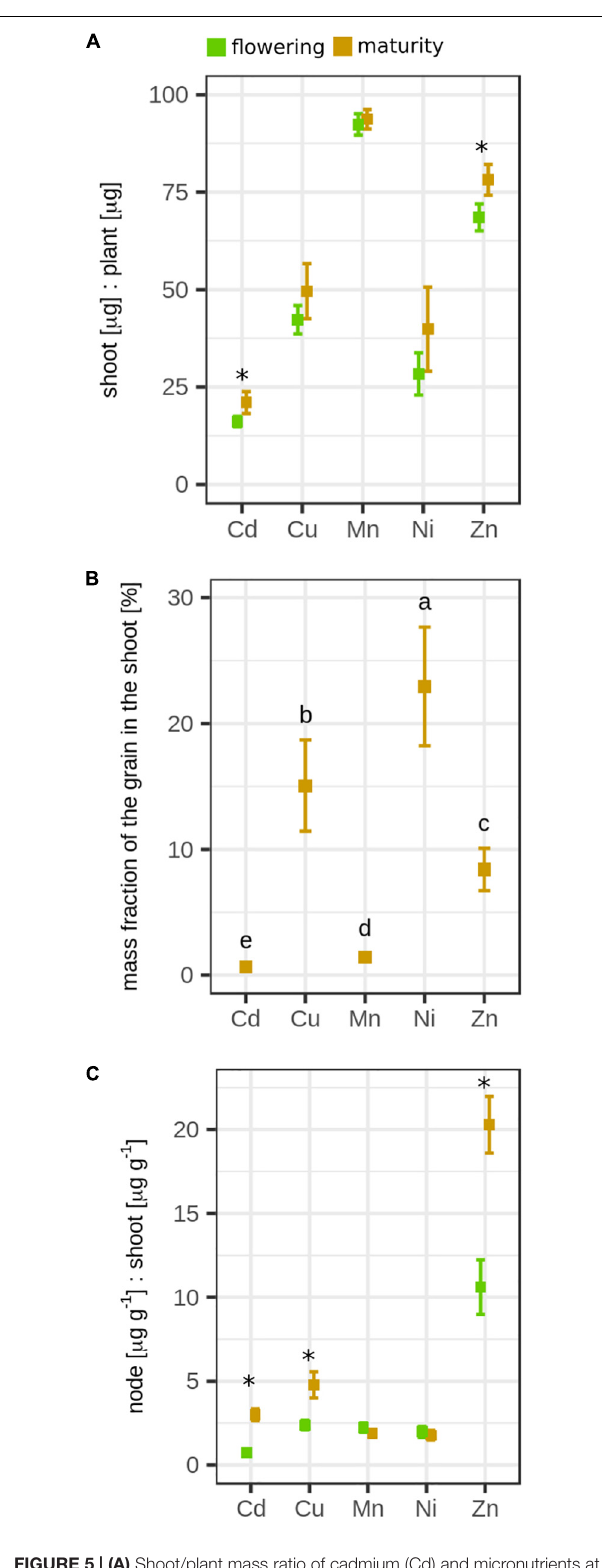
FIGURE 5 | (A) Shoot/plant mass ratio of cadmium (Cd) and micronutrients at flowering and maturity. Error bars denote standard deviation of the mean of